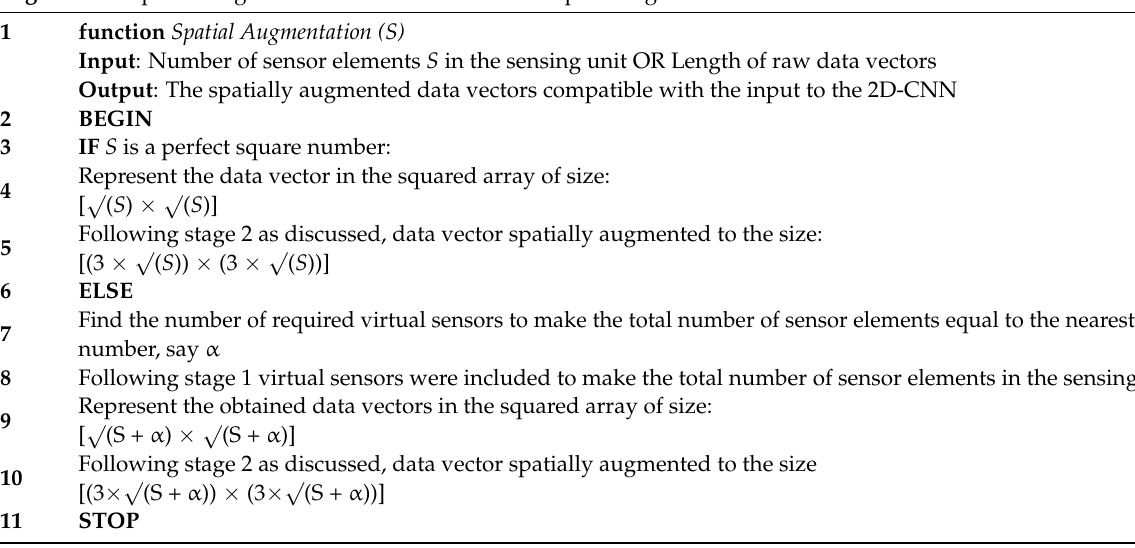
Algorithm 1 Spatial Augmentation Procedure for Data Up-Scaling function Spatial Augmentation